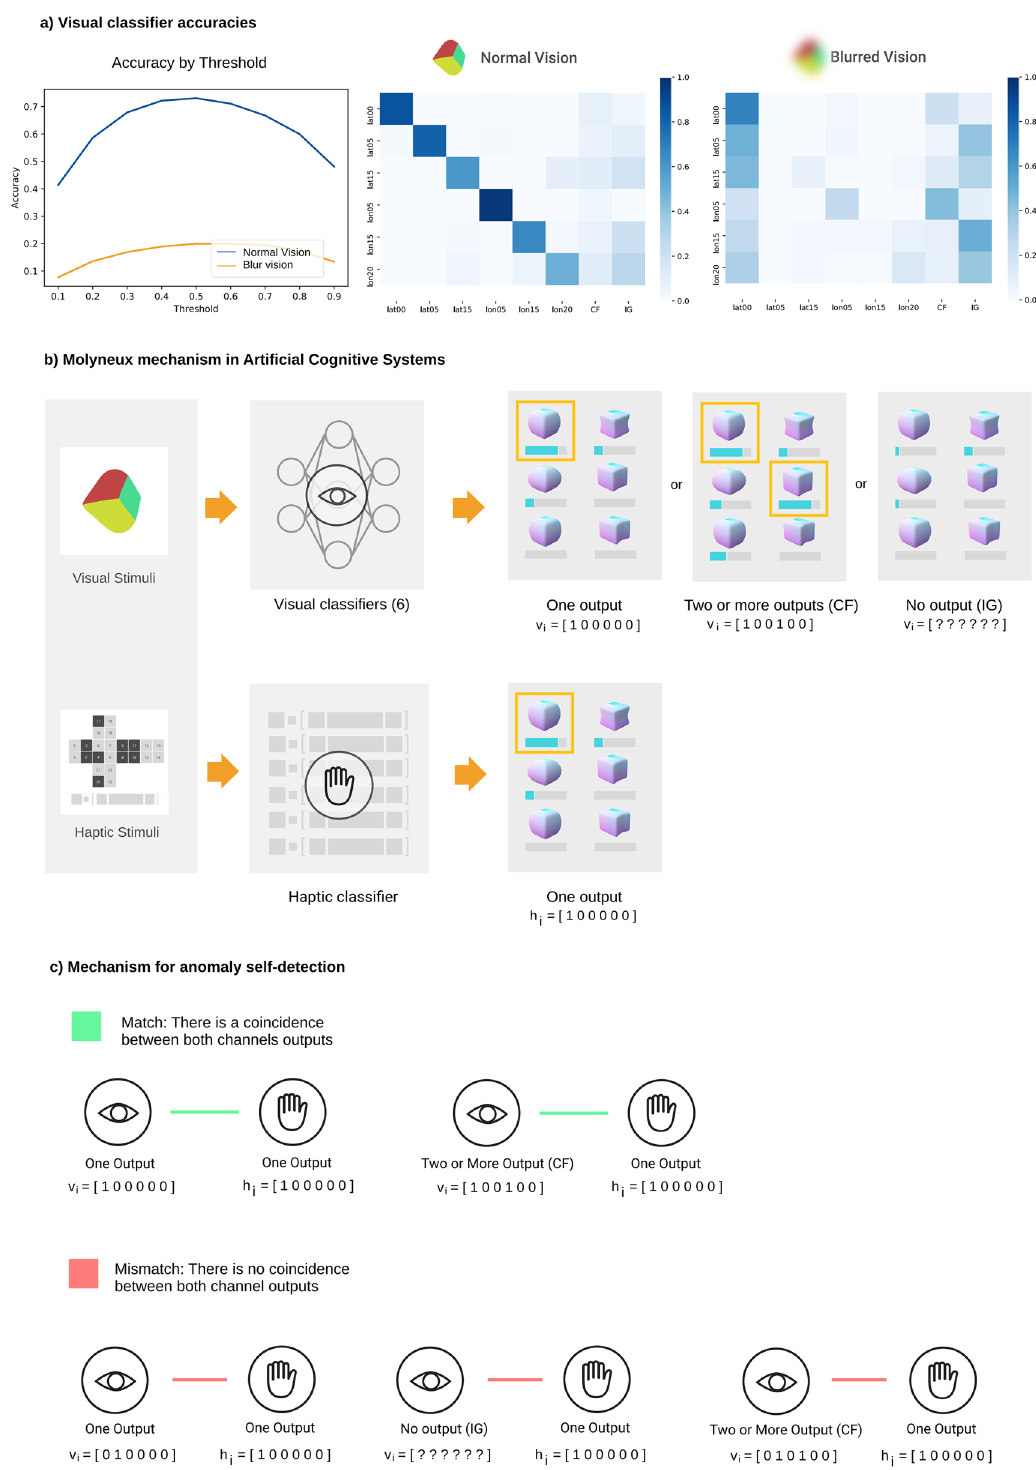
Figure 4. Visual classifier threshold and the Molyneux mechanism. ( a ) With the synthesized video generated from human object manipulation, we trained a one-vs-all based CNN model, generating an individual classifier for each class. In order to determine the output label of a classifier, we have studied which accuracy threshold results in the best performance of the visual model. By setting the threshold to 0.5, we obtain the confusion matrices shown at the bottom after testing the model with normal vision images (like the ones used for training) and blurred vision images. ( b ) Classifier Module. Every video frame and its corresponding haptic state are classified by the visual and haptic object recognition systems, respectively. There are three possible outputs of the visual recognition system: (i) a single class, (ii) multiple classes (CF), or (iii) none (IG). On the other hand, the label from the haptic recognition system is always univocal. (c) Molyneux Module. By applying the Molyneux mechanism, we check if visual and haptic recognition agree,